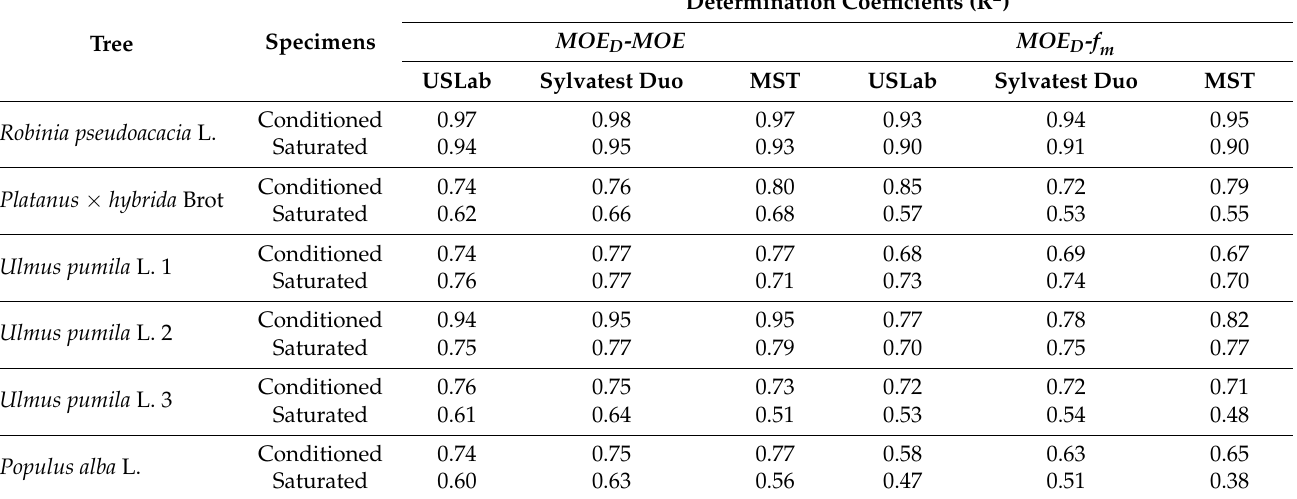
Table 6. Determination coefficients values between dynamic modulus of elasticity ( MOE D ) and static modulus of elasticity ( MOE) , and determination coefficients values between MOE D and bending strength ( f m